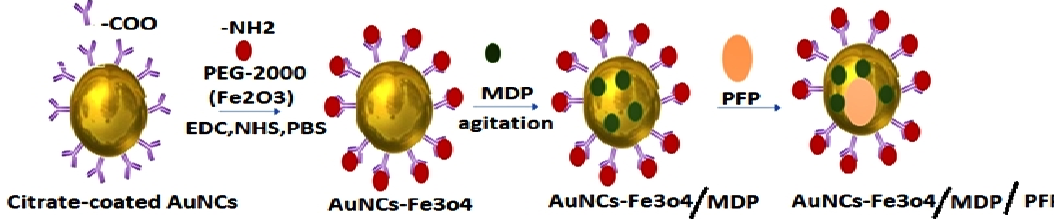
Figure 4. Conjugated (AuNCs-Fe 3 O 4 ) nanoparticulate system modified to encapsulate the muramyl dipeptide (MDP) and perfluoropentane (PFP) to develop AuNCs-Fe 3 O 4 /MDP/PF.